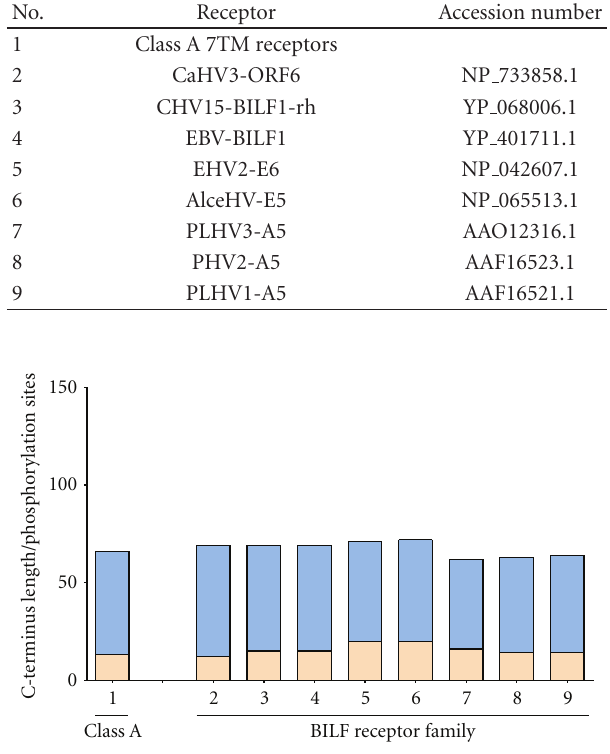
Figure 4: Relative sequence length and putative phosphorylation sites of the C-terminal region of class A 7TM receptors and the BILF-like receptors. The vertical axis displays the number of amino acids of the C-terminus (blue), defined as being after the highly conserved proline of the NPxxY-motif (class A 7TM receptors) or predicted by the Transmembrane Hidden Markov model using Geneious Pro (BILF receptor family), and the number of serine, threonine, and tyrosine in this region (beige). The horizontal axis displays the average of 334 non-olfactory class A 7TM receptors (1) and the EBV-encoded BILF receptors (2–9). For further details about specific receptors and GenBank accession number please